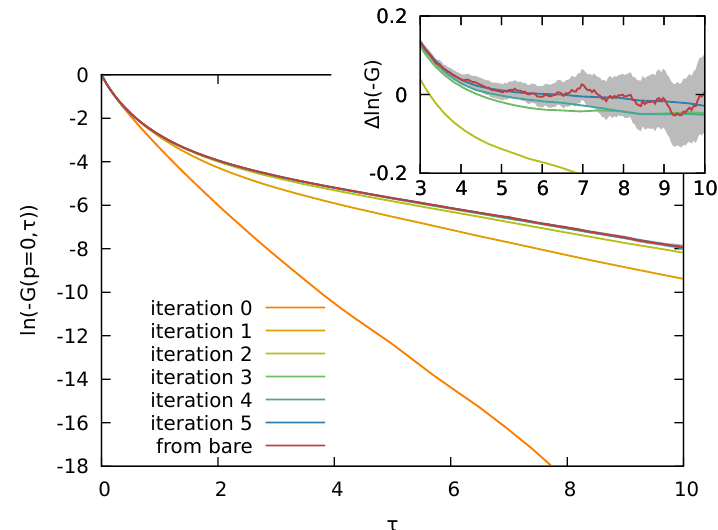
Figure 24: The Green function G ( p = 0, τ ) obtained in the bold approach for α = 5 and µ = − 6. Shown are the first six iterations (bottom to top, obtained by sampling) with the initial guess G = G and compared to the result obtained in the bare expansion. Error bars 0 on the latter are indicated by the shaded region. We used 256 points in imaginary time on a logarithmic grid and 2 13 Matsubara frequencies. We took 200 equidistant points in momentum = 100. The inset shows the same data with the asymptotic space with a momentum cutoff at k c line fit from Fig. 9a subtracted, ∆ ln ( − G ) = ln ( − G ) − ( a + b τ )